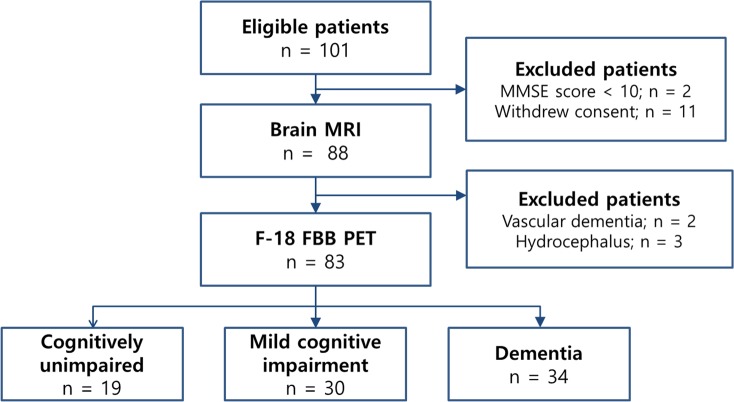
Flow diagram of the study population.